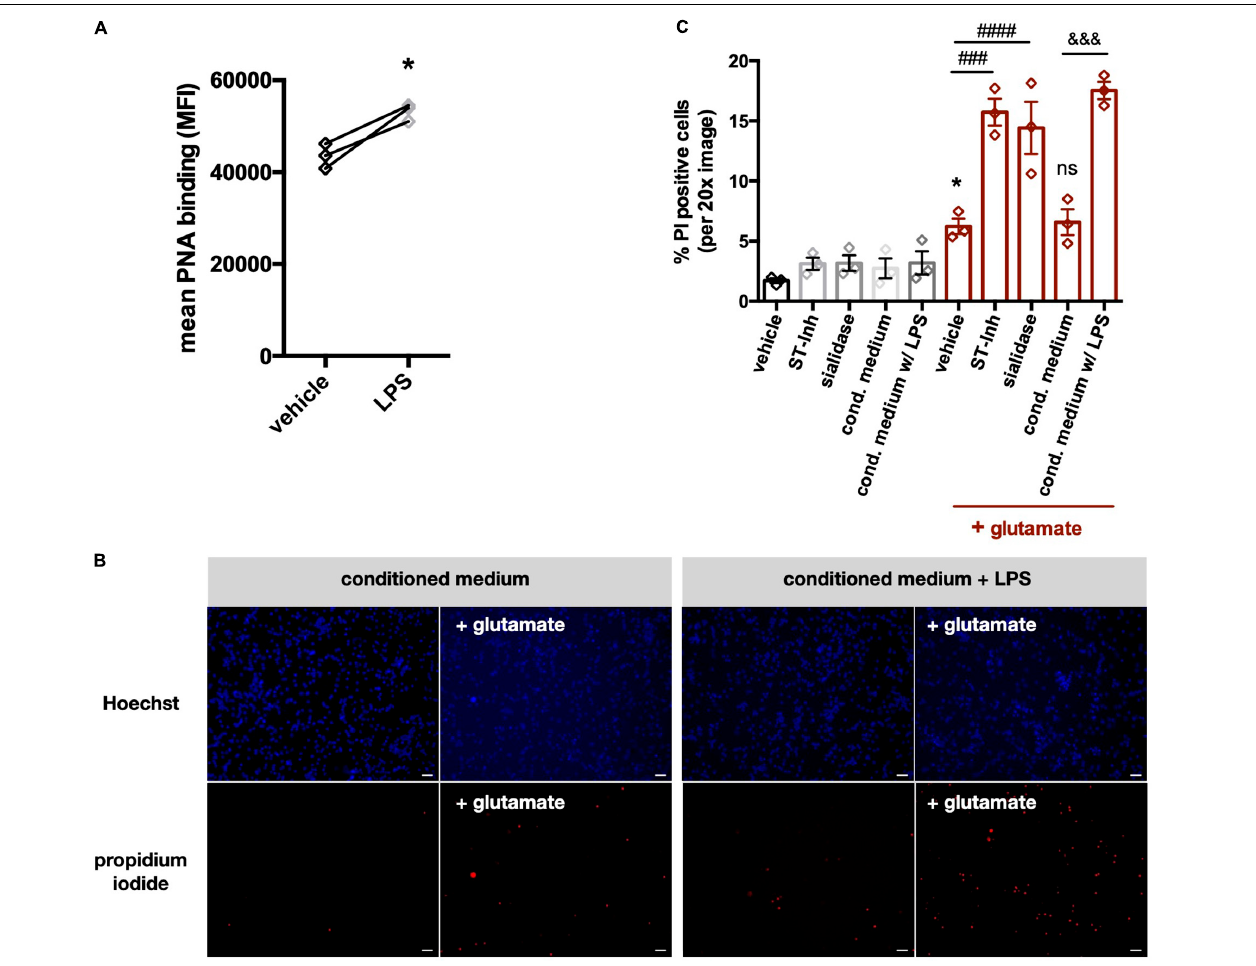
FIGURE 7 | Conditioned media from LPS-stimulated microglia induce desialylation in neuronal-glial co-cultures and sensitize neurons to glutamate-induced excitotoxicity. (A) Peanut agglutinin binding to neuronal-glial co-cultures that were pretreated with (i) conditioned media from primary glial cultures (vehicle) or (ii) conditioned media from LPS-stimulated (i.e., 100 ng/ml, 18 h) primary glial cultures (LPS). Binding was measured by flow cytometry on live cells and data presented as mean fluorescent intensities of the PNA-FITC dye. Statistics: paired t -test, * p < 0.05. (B) Neuronal-glial co-cultures were treated for 1 h with conditioned medium from unstimulated microglia or conditioned medium from LPS-stimulated microglia. Sodium glutamate (100 µ M) was then added for 5 h and propidium iodide (PI) positive neurons were counted. Representative images of Hoechst and propidium iodide stained neuronal-glial co-cultures after treatment with conditioned media (with or without LPS) at 20x magnification. Scale bar − 75 µ m. (C) Quantification of PI positive cells in neuronal-glial cultures, which where desialylated with either sialidase, sialyltransferase inhibitor (ST-Inh) or conditioned medium (cond. medium) from LPS-treated primary rat microglia, and then stimulated with 100 µ M glutamate. Data represents mean PI positive cells ( ± S.E.M) of at least 6 images from 3 independent neuronal-glial cultures. * p < 0.05 vs. vehicle + no glutamate; ### p < 0.001, #### p < 0.0001 and ns (non-significant) versus vehicle + glutamate: &&& p < 0.001 versus conditioned medium + glutamate. extracellular neuraminidase in BV-2 and primary rat